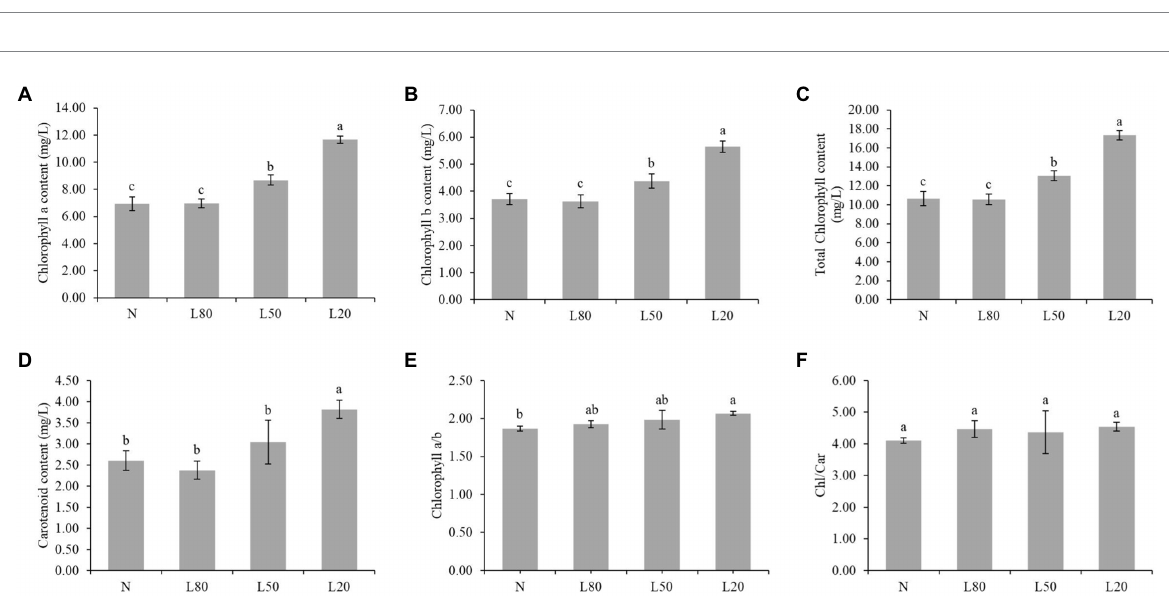
FIGURE 4 Changes in photosynthetic pigments of J. mandshurica under shade. (A) Chlorophyll a content. (B) Chlorophyll b content. (C) Total chlorophyll content. (D) Carotenoid content. (E) Chlorophyll a/b. (F) Chlorophyll/Carotenoid. N: natural sunlight. L80: 80% sunlight to go through. L50: 50% sunlight to go through. L20: 20% sunlight to go through. Error bars represent the standard error. Different letters indicate significant differences between different